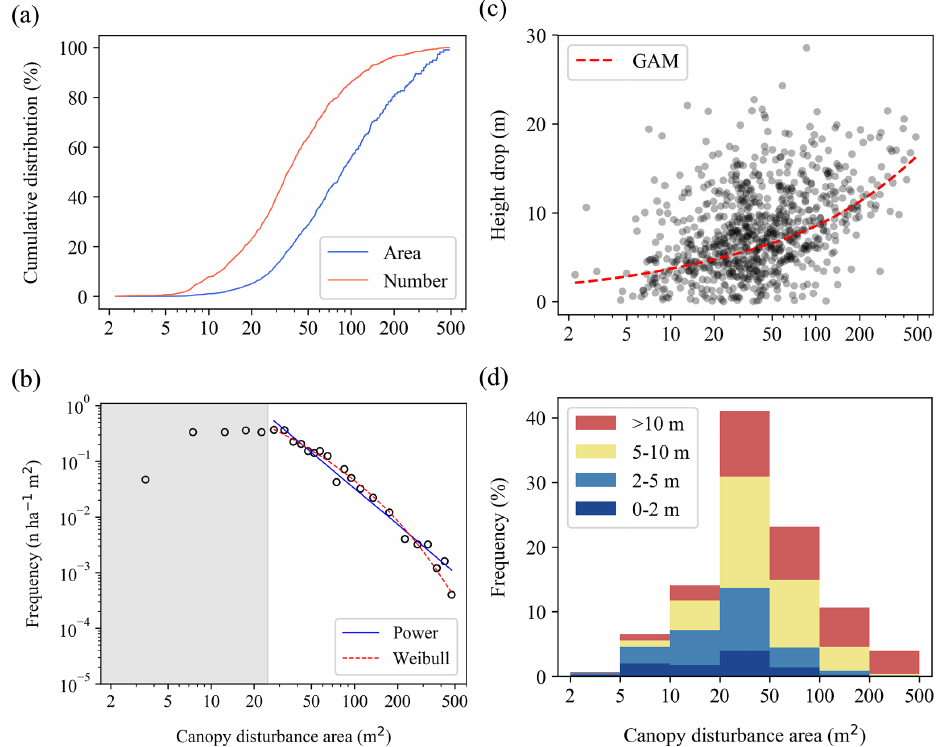
Figure 6. Size structure of canopy disturbances. (a) Cumulative number and area of canopy disturbances in relation to their area. (b) Size dis- tribution of canopy disturbances, together with Weibull and power function fits for canopy disturbances larger than 25m 2 (this threshold was chosen because we are confident we identified all canopy disturbances above this area, but we may have missed some smaller ones). (c) Re- lationship of mean vertical height drop to horizontal area among canopy disturbances (points), together with a GAM fit (red line) to illustrate the trend. (d) Distribution of canopy disturbances across area and height drop classes. The shaded gray in (b) indicates a canopy disturbance area lower than the 25m 2